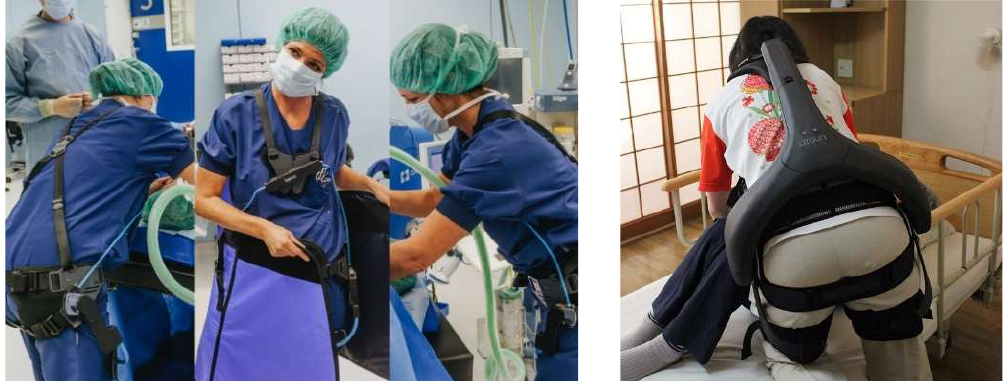
Figure 1. Exemplary devices are passive (see left photo, Laevo [16]) and active (see right photo, Atoun Model Y [14]) exoskeletons applied so far for healthcare